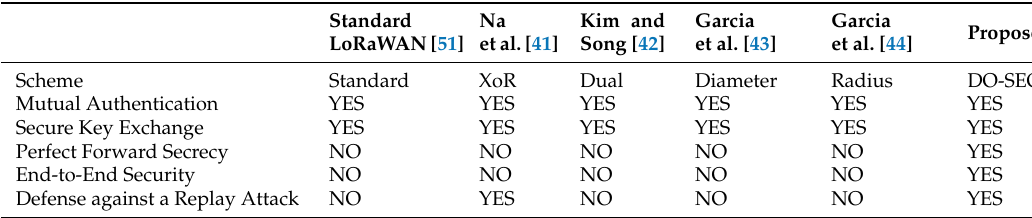
Table 2. Comparisons of different LoRaWAN